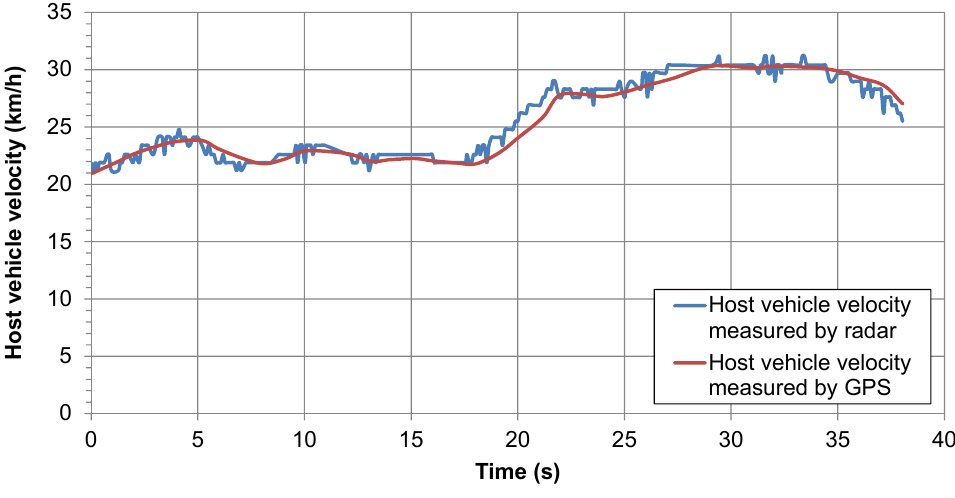
Figure 7. Example host vehicle velocity measurement comparison.